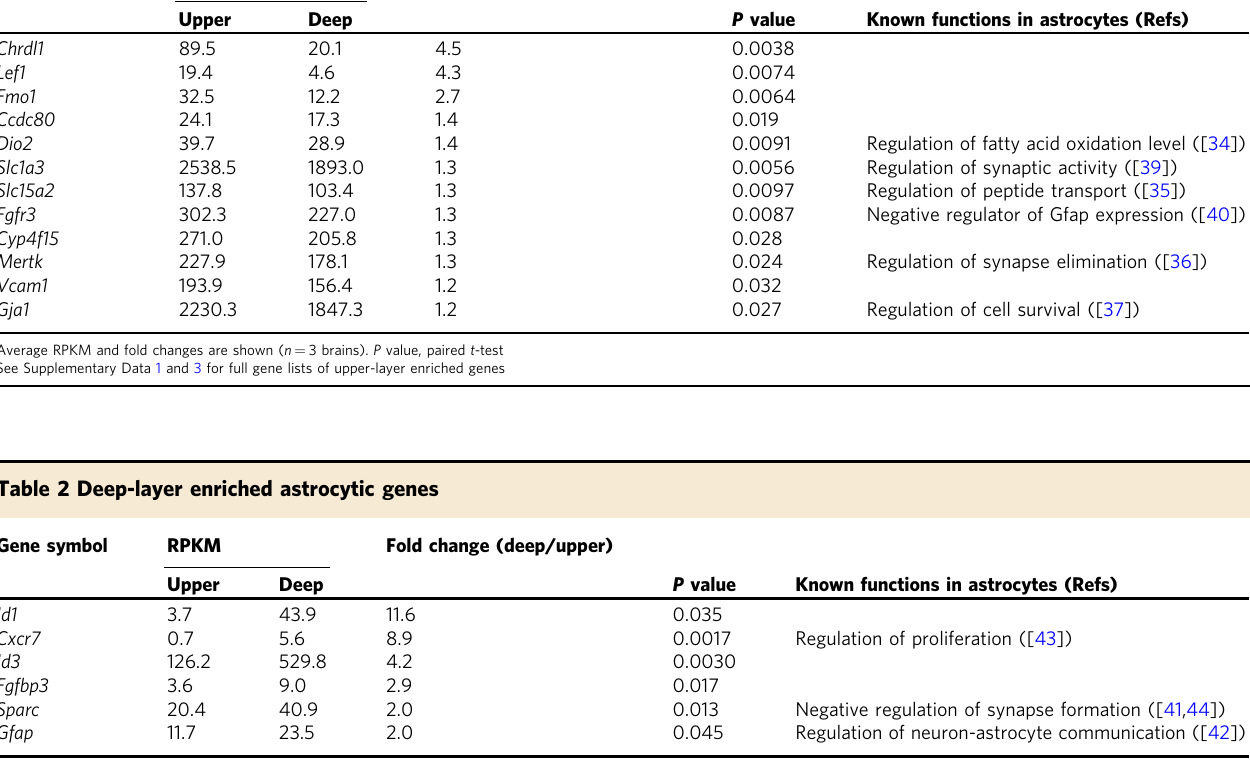
Table 1 Upper-layer enriched astrocytic genes Gene symbol